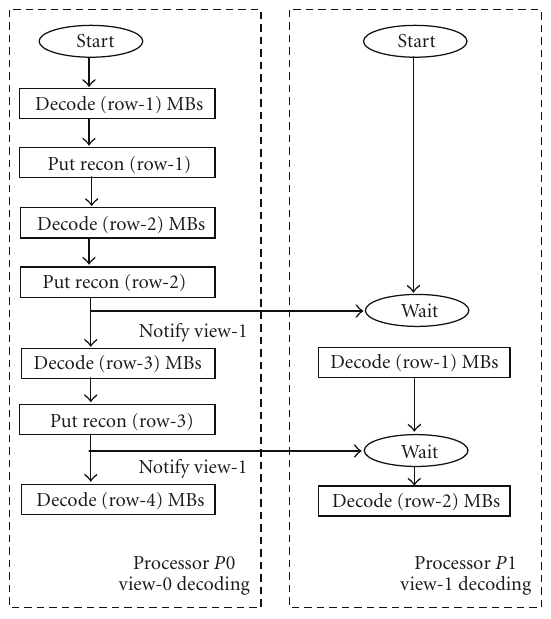
Figure 9: Sample parallel decoding process for two